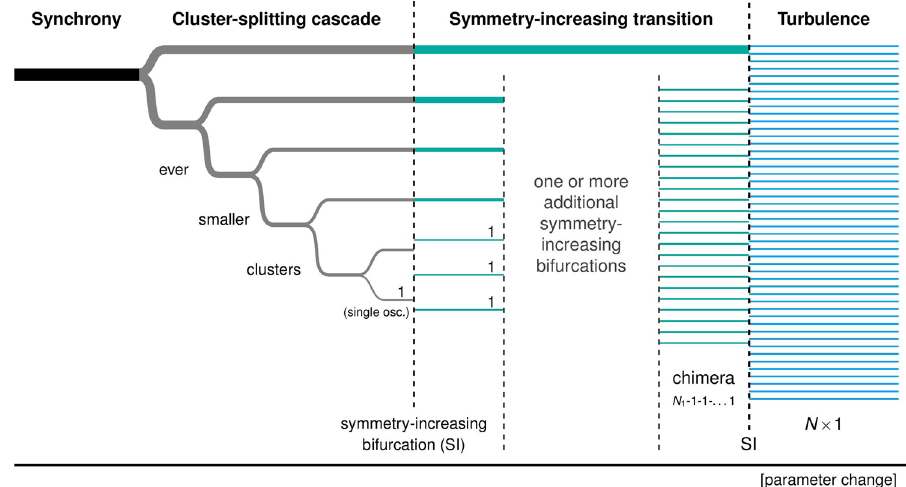
Fig. 10 Ideal transition from synchrony to turbulence. The synchronized state is initially broken into two clusters. These clusters are in turn split into successively smaller clusters in a cluster-splitting cascade. When the smallest cluster is just a single oscillator, a symmetry-increasing bifurcation occurs. Hereby, one or more clusters are abruptly broken into single oscillators that henceforth all behave equally in the long run. Additional symmetry-increasing bifurcations ultimately lead to a turbulent state of only single oscillators. The last step but one is often a chimera